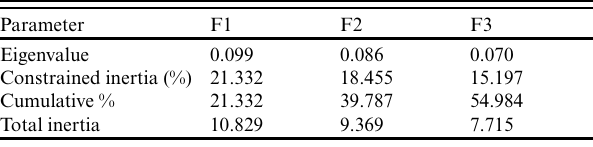
Table 7. Redundancy analysis results for the reasons for prioritizing the principles of success in Tumaco.